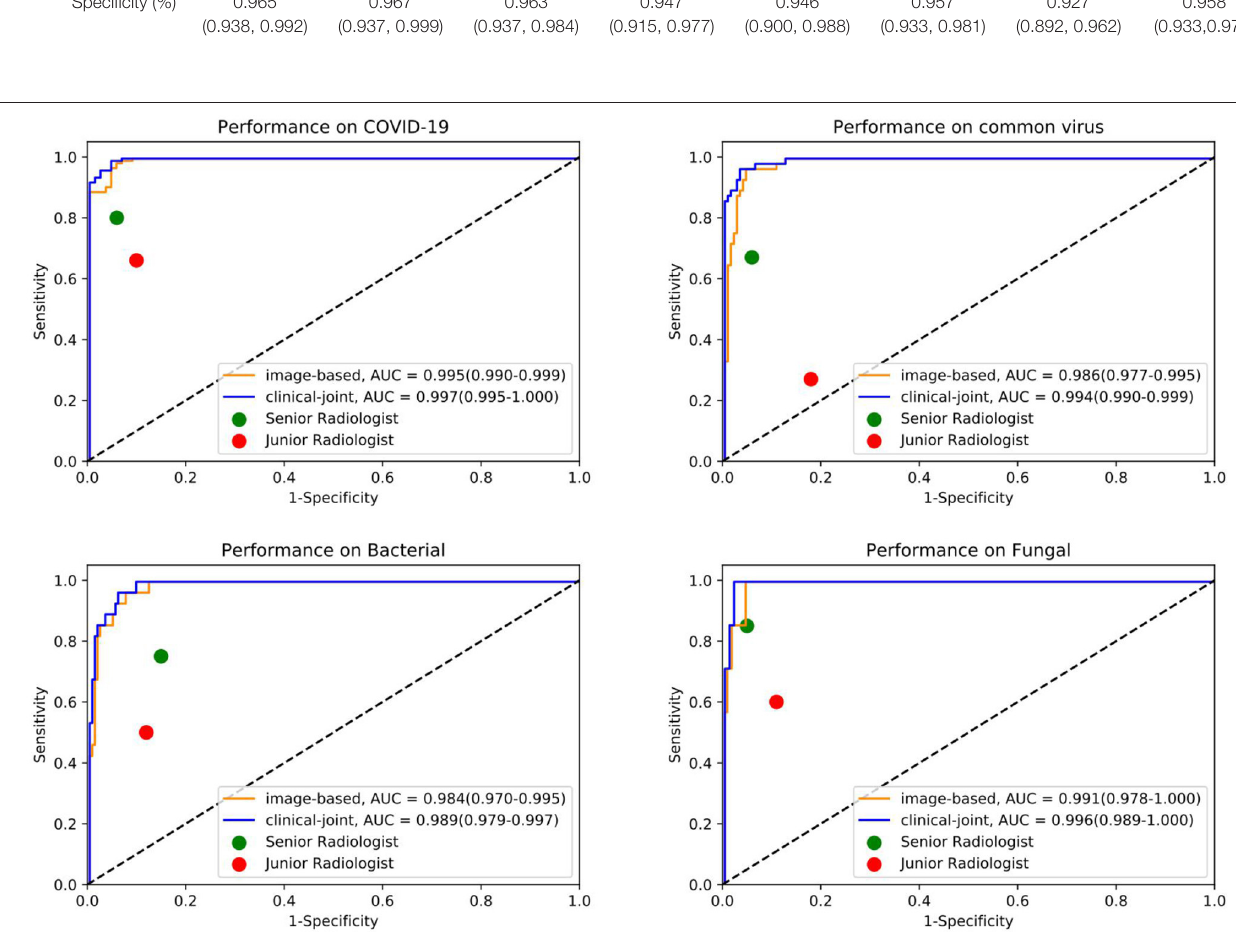
FIGURE 3 | The individual ROC curves of our image-based DL system and clinical-joint ML system in classifying the four pathogens of pneumonia on testing dataset. In the observer performance test, the AI system performed much better than all reader groups in terms of four type classification.